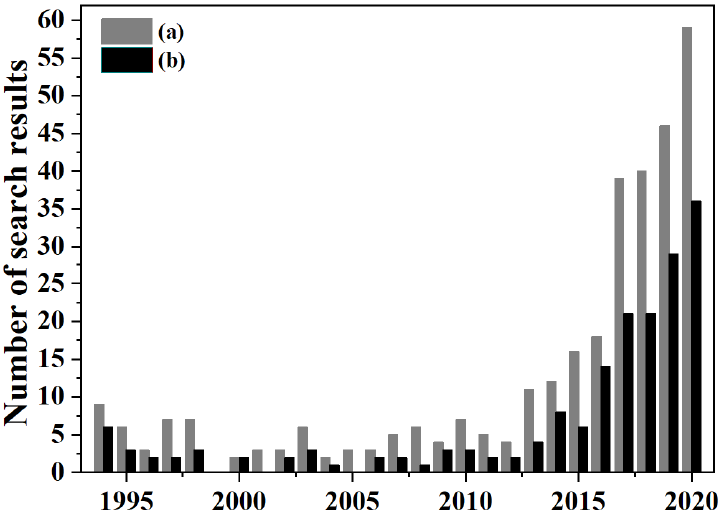
Figure 4. Chronological distributions of patent search results between 1994 and 2020 obtained using the keyword sets (a): oxidative, methane and coupling; and (b): oxidative, methane, coupling and ethylene.